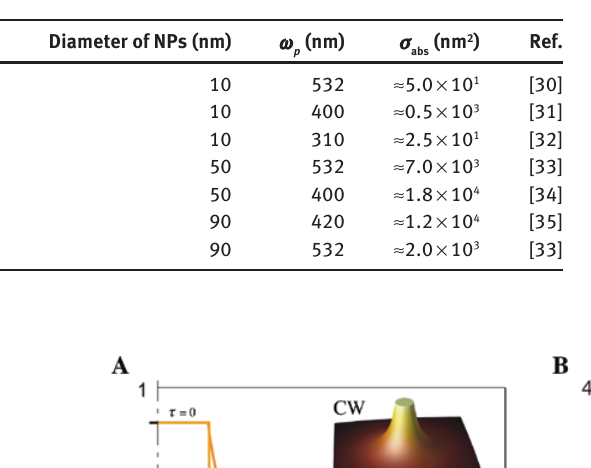
Table 1: Comparison of the absorption cross-section for different plasmonic NPs.